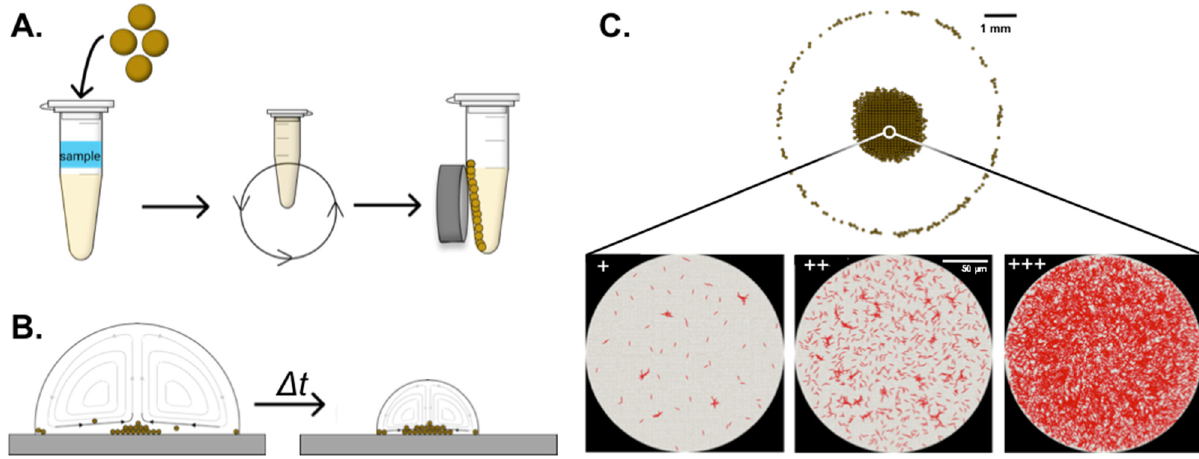
Figure 2. Workflow for combined volumetric and spatial concentration of M.tb . ( A ) Magnetic nanoparticles are added, incubated with the sample to capture bacilli, and then magnetically separated from the sample. After washing, the bound sample and nanoparticles are recovered in 50 μ L PBS-T. ( B ) The recovered sample is deposited on the Rain-X ® + poly-L-lysine-coated microscope slide and evaporated at room temperature over a period of time ( Δ t). ( C ) The dried sample is stained using the Ziehl–Neelson method, and the central Marangoni deposition area is inspected using microscopy at 1000× magnification. Representative positive samples with increasing M.tb concentrations are shown. (+)—10 4 bacilli/mL; (++) 10 5 bacilli/mL; (+++) 10 6 bacilli/mL. Black scale bar—1 mm; white scale bar—50 μ m.